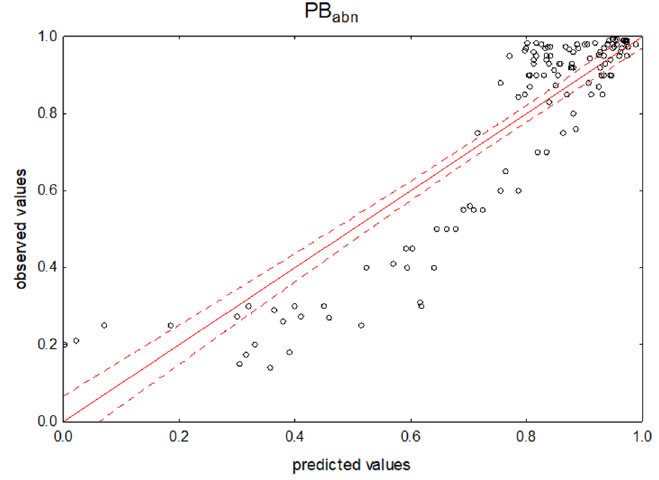
Figure 1. Predicted vs. observed values for the multiple linear regression (MLR) model using NP TLC retention data. Dependent variable: PB abn .